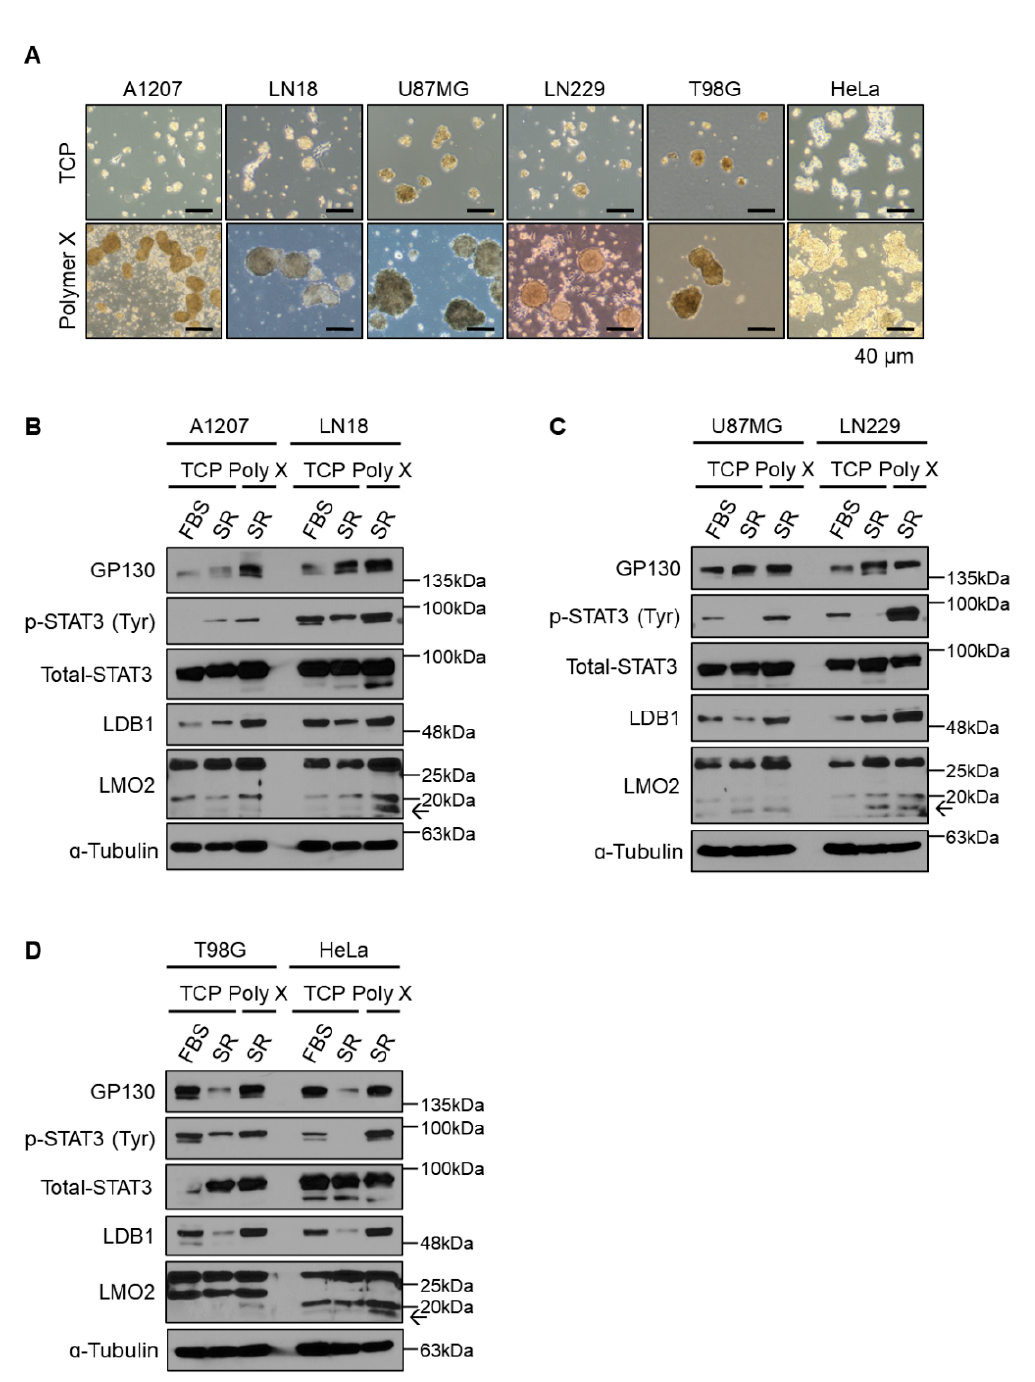
Figure 5. General application of polymer X using various cancer cell lines. ( A ) Images of tumor spheroids cultured in each indicated cell line on TCP or polymer X for 8 days. Scale bar, 40 µm. ( B ) Cell lysates from A1207 and LN18 GBM cells cultured on TCP or polymer X for 8 days were immunoblotted with antibodies specific to GP130, p-STAT3, total STAT3, LMO2, LDB1, and α -tubulin. ( C ) Cell lysates from U87MG and LN229 GBM cells cultured on TCP or polymer X for 8 days were immunoblotted with antibodies specific to GP130, p-STAT3, total STAT3, LMO2, LDB1, and α -tubulin. ( D ) Cell lysates from T98G GBM cells and HeLa cells cultured on TCP or polymer X for 8 days were immunoblotted with antibodies specific to GP130, p-STAT3, total STAT3, LMO2, LDB1, and α -tubulin. The arrow means LMO2.